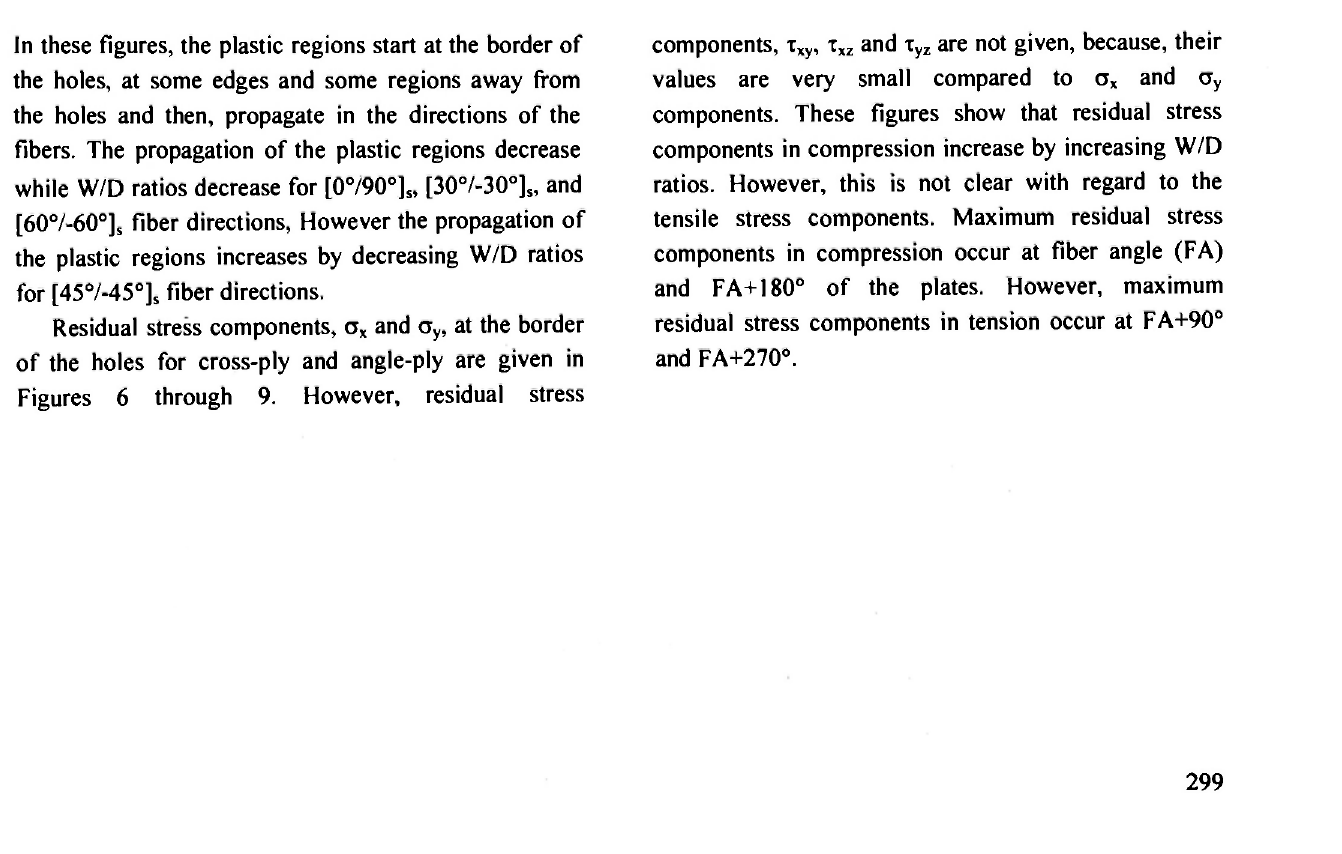
Fig. 5: The plastic region of the angle-ply plates, [60°/-60°] s : a) W/D=10, b) W/D=8,